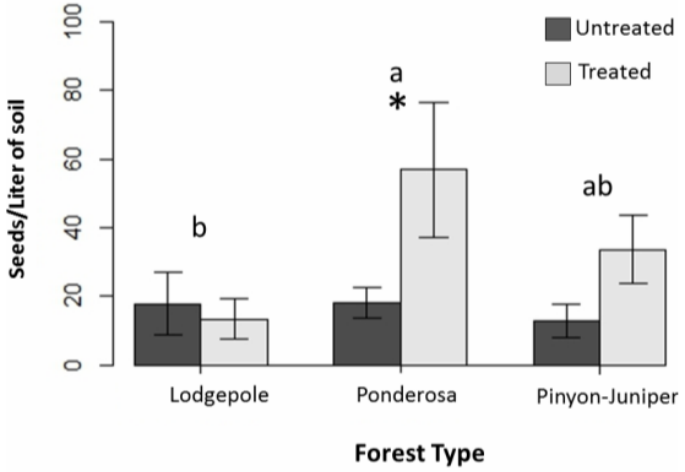
Figure 1. Seed densities per L of sifted mineral soil by forest type and treatment.